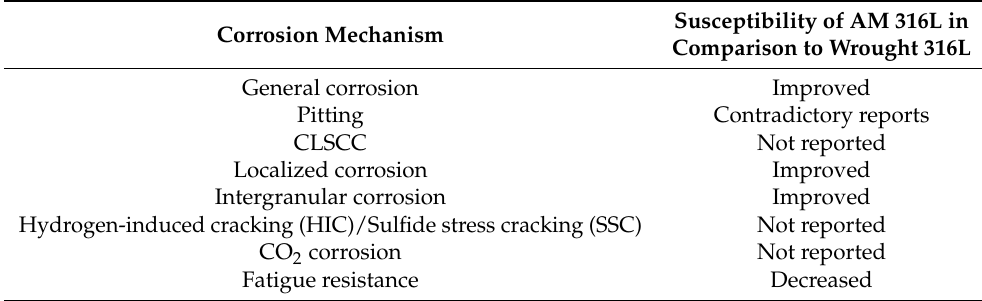
Table 5. Comparison of the corrosion susceptibility of additively manufactured 316L and wrought 316L material